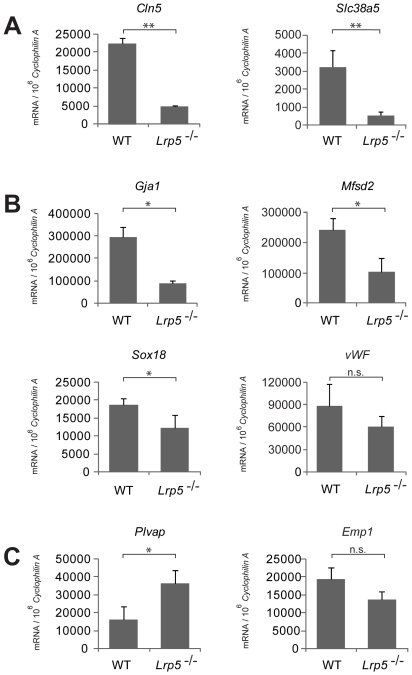
Confirmation of gene expression differentially regulated in Lrp5 null retina with RT-qPCR.Quantification of mRNA (A) Cln5 and Slc38a5, (B) Gja1, Msfd2, Sox18, and vWF, and (C) Plvap and EMP1 in WT and Lrp5 null retina with RT-qPCR at P8. Expression levels were normalized against housekeeping gene Cyclophilin A. *p<0.05, **p<0.01.